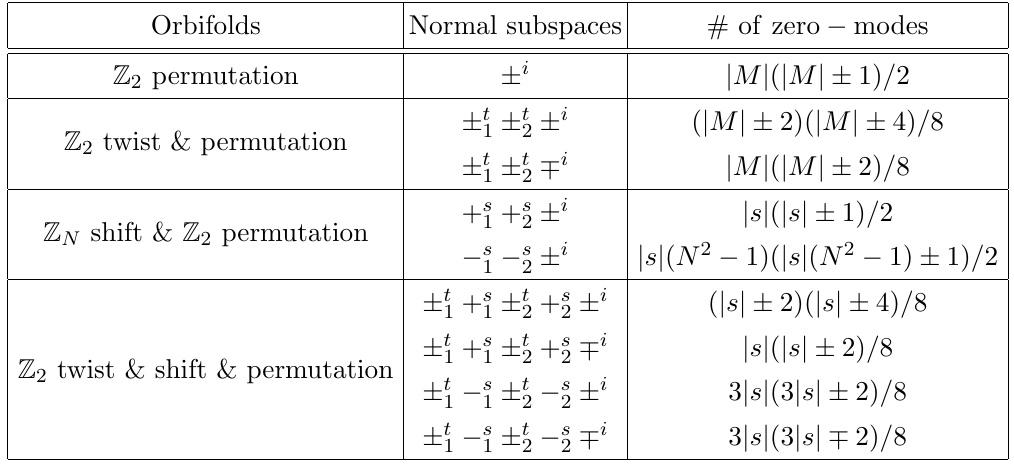
) = Z N twist, shift (cid:2) T 2 1 2 (cid:2) T 2 ) = Z N . The last column shows the number of 1 2